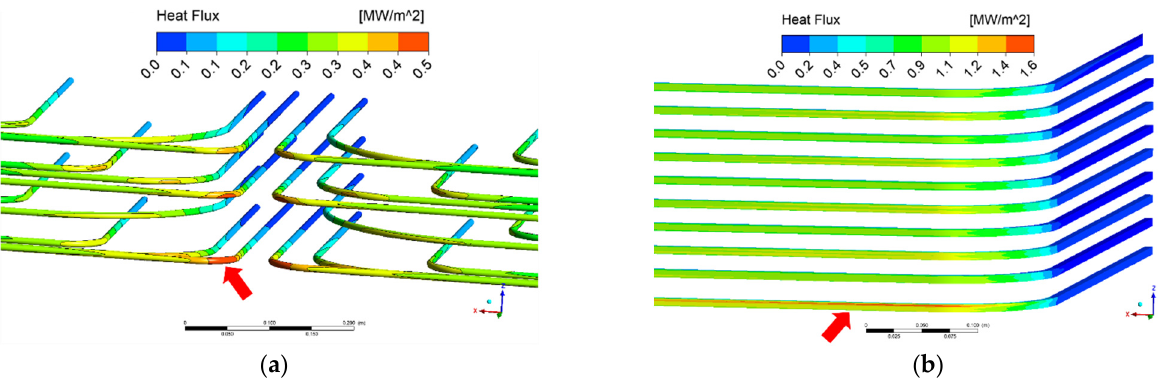
Figure 10. ( a ) View of the BZ cooling system and ( b ) view of the FW cooling system. The hot spots are marked by the arrow symbols.